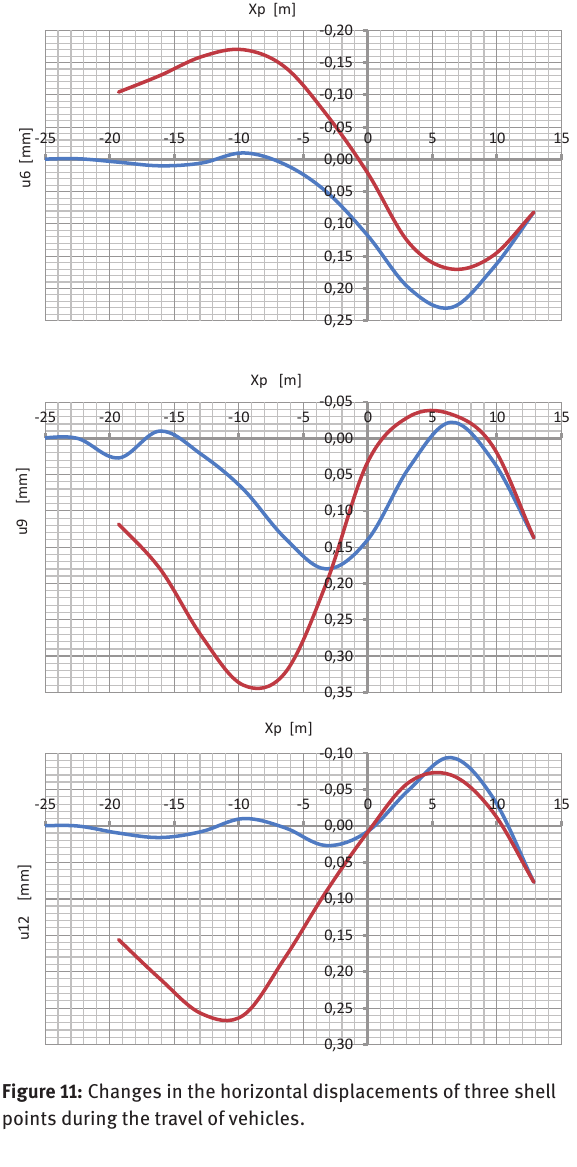
Figure 11: Changes in the horizontal displacements of three shell points during the travel of vehicles.